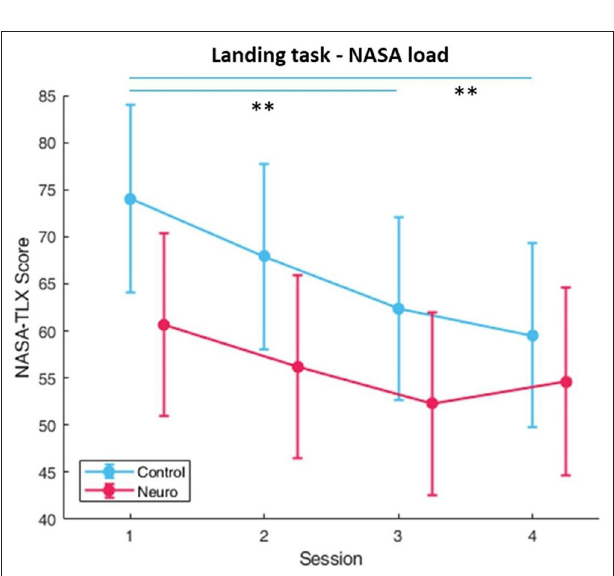
FIGURE 5 | Subjective workload calculated by sum of NASA-TLX. Significant condition by level differences were found (whiskers are SEM, ** p < 0.01).